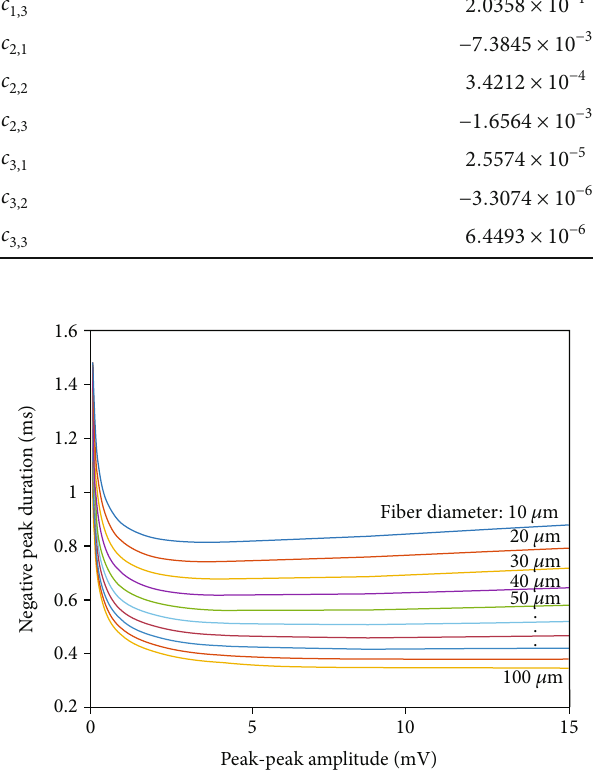
Figure 2: The quadratic relation between the peak-peak amplitude and the negative peak duration under di ff erent values of fi ber